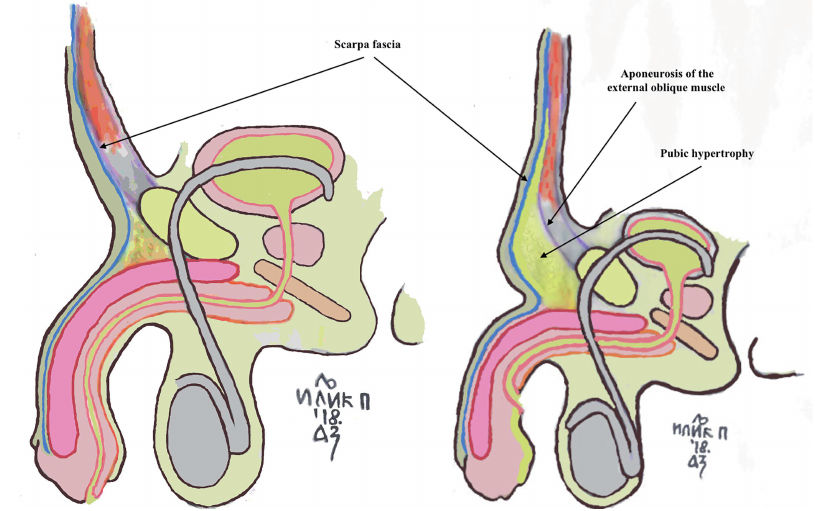
Figure 1 - Comparison between physiological and pathological suprapubic fat tissue in patients with hypospadias.